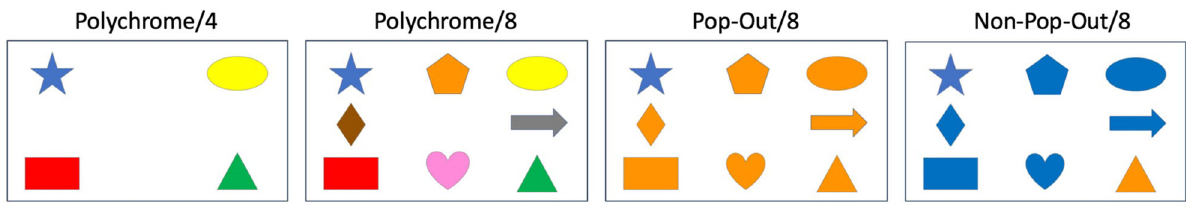
Fig. 3 Sample items from the four conditions in Experiment 1. Eye movements and response times were used to measure target identi fi cation during language processing. The target in all four displays was the star, and the instructions included bare de fi nite descriptions ( “ Click on the star ” ) and